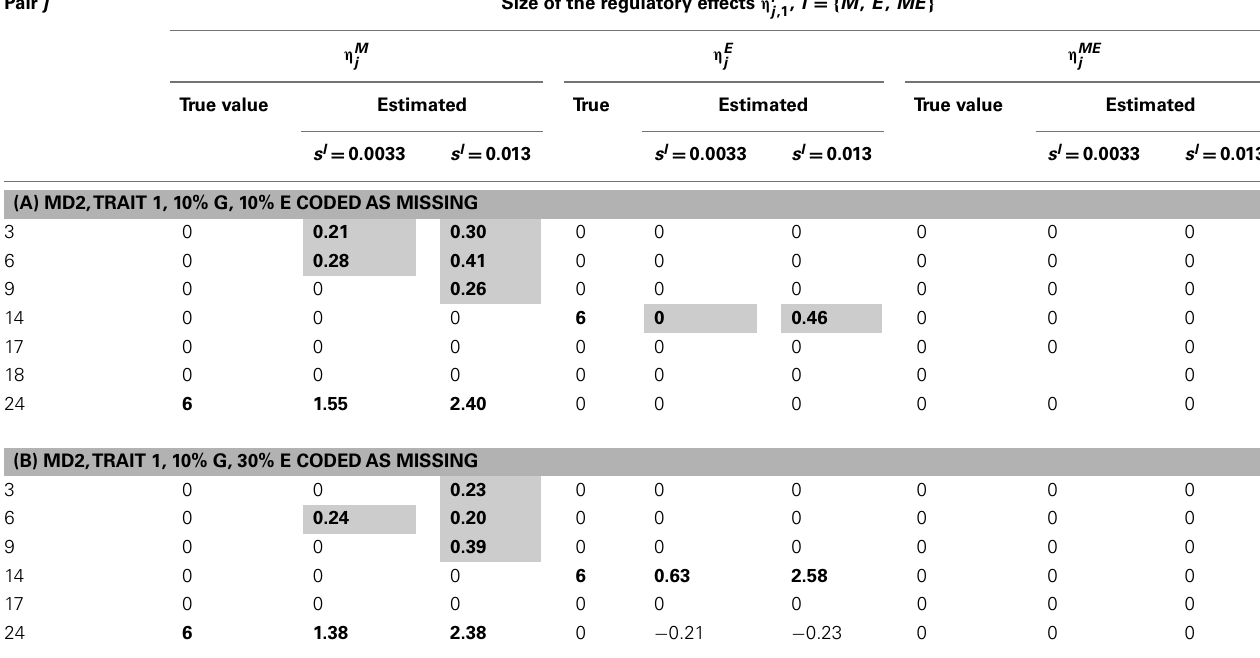
Table 7 |True and estimated (posterior means) cQTL effects in the analysis ofTrait 1 using the MD2 version of the HB single-trait cQTL model with (A) 10% markers and 10% expressions coded as missing and (B) 10% markers and 10% expressions coded as missing, and different values of s l